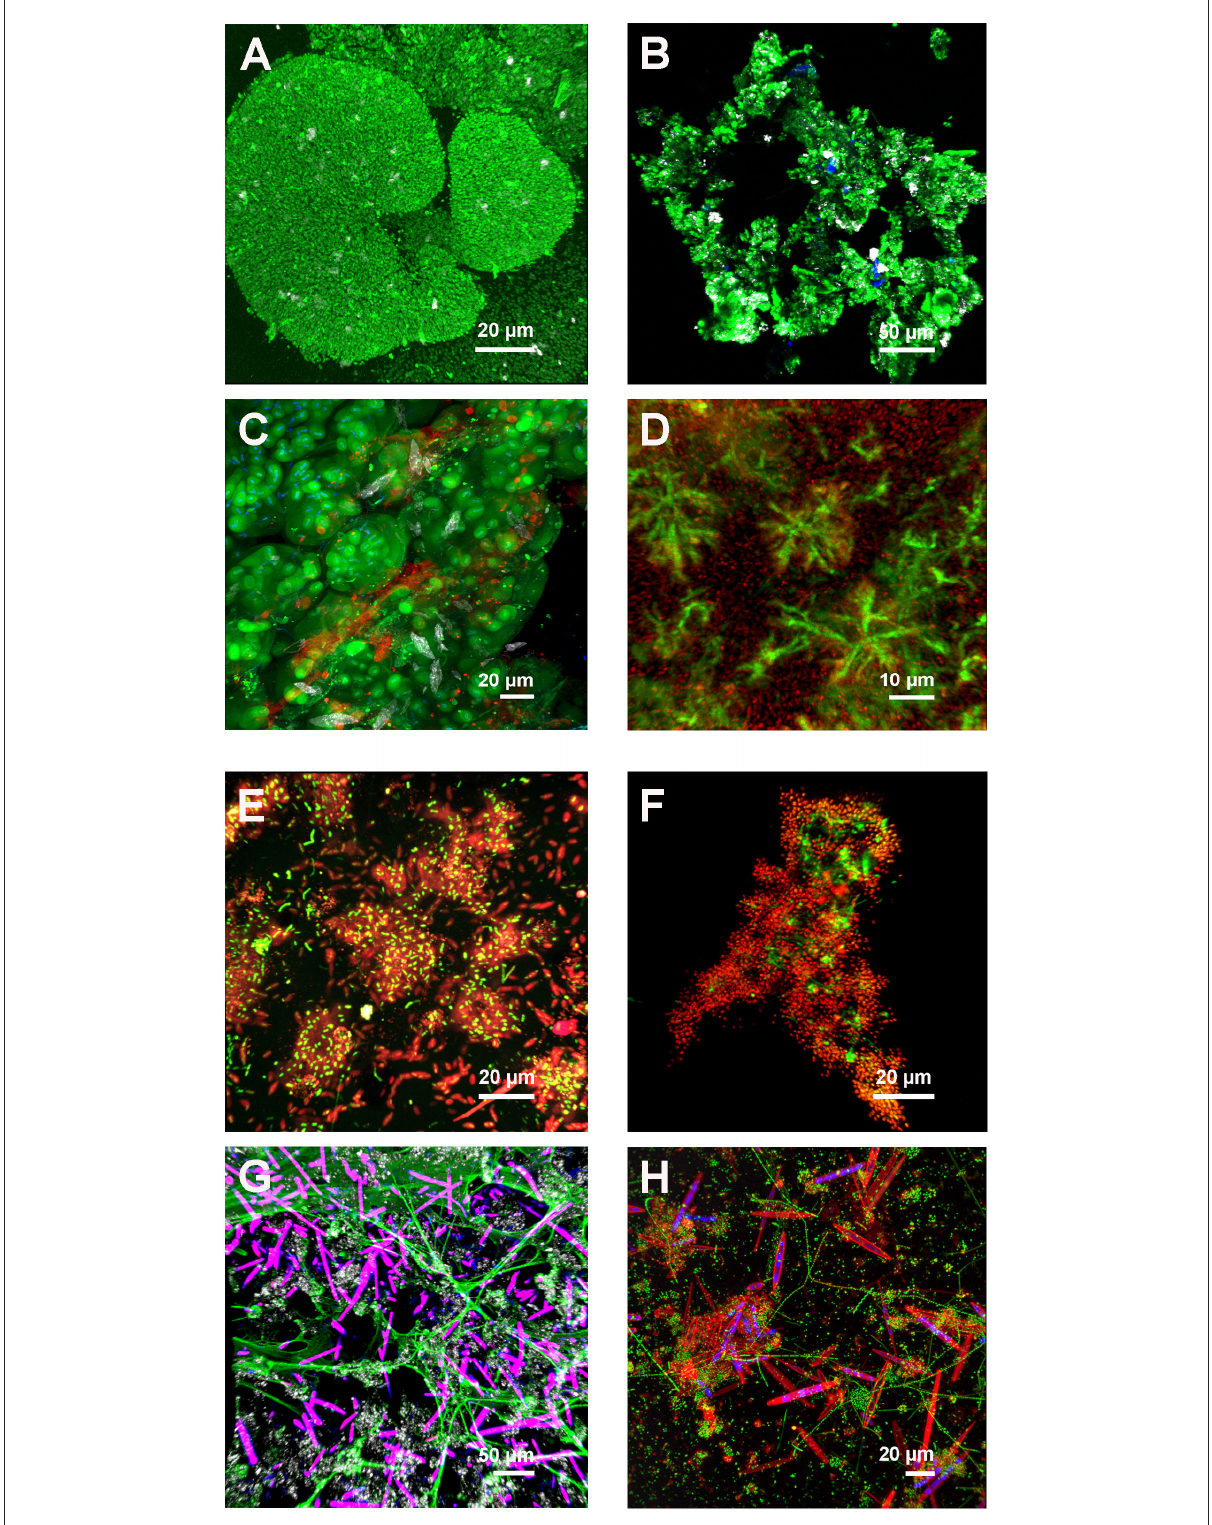
FIGURE1 Examples of different lectin patterns from environmental biofilm and bioaggregate samples. The multichannel, 3-dimensional data sets recorded by CLSM and projected as maximum intensity projection (MIP) indicate a variety of lectin-specific glycoconjugates. (A) Reactor